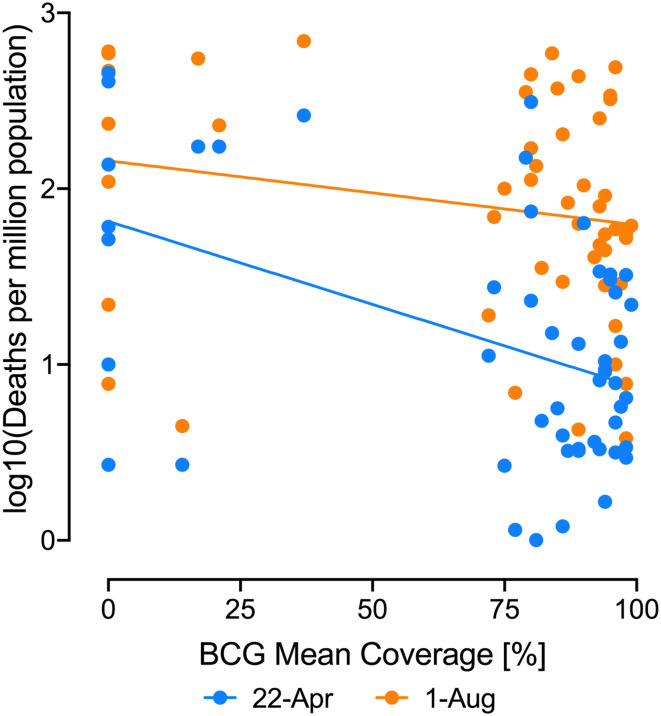
Association between percentage of vaccination coverage and maximum COVID-19 deaths per million inhabitants registered by country. Log10 deaths per million inhabitants vs. percentage of bacillus Calmette–Guérin vaccination coverage. Data from April 22, 2020, blue dots and line (Pearson r = 0.46, P = 0.0006), and data from August 1, 2020, orange dots and line (Pearson r = 0.2, P = 0.16).